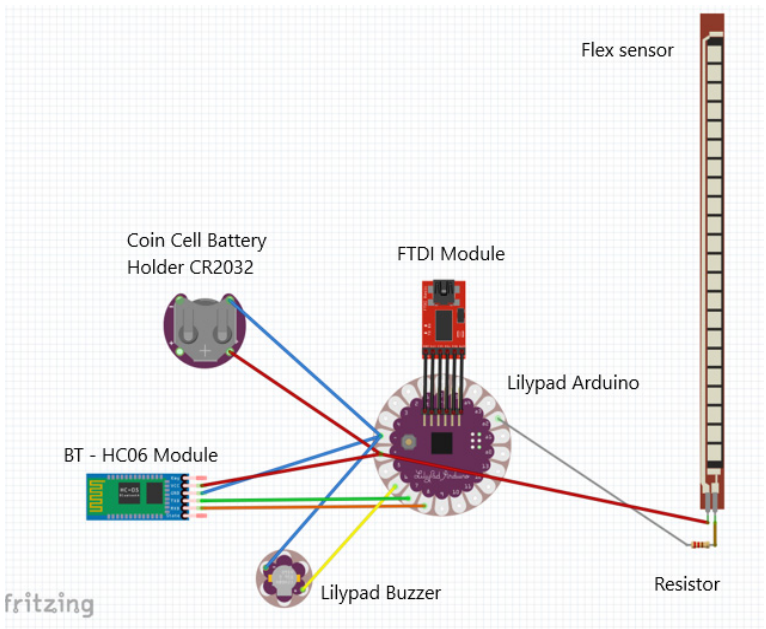
Figure 2. Block diagram of the embedded system. The electric connections between the components are shown.